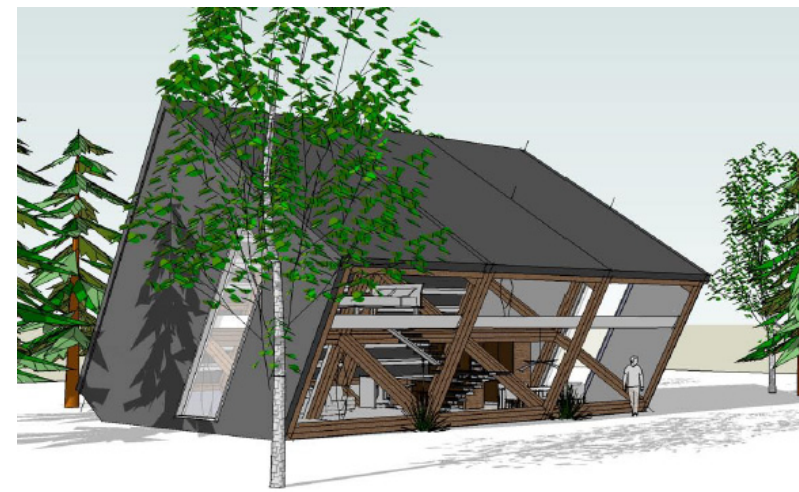
Figure 1. Rendering of the model house’s facade (Courtesy of Gau Designs & Concepts).